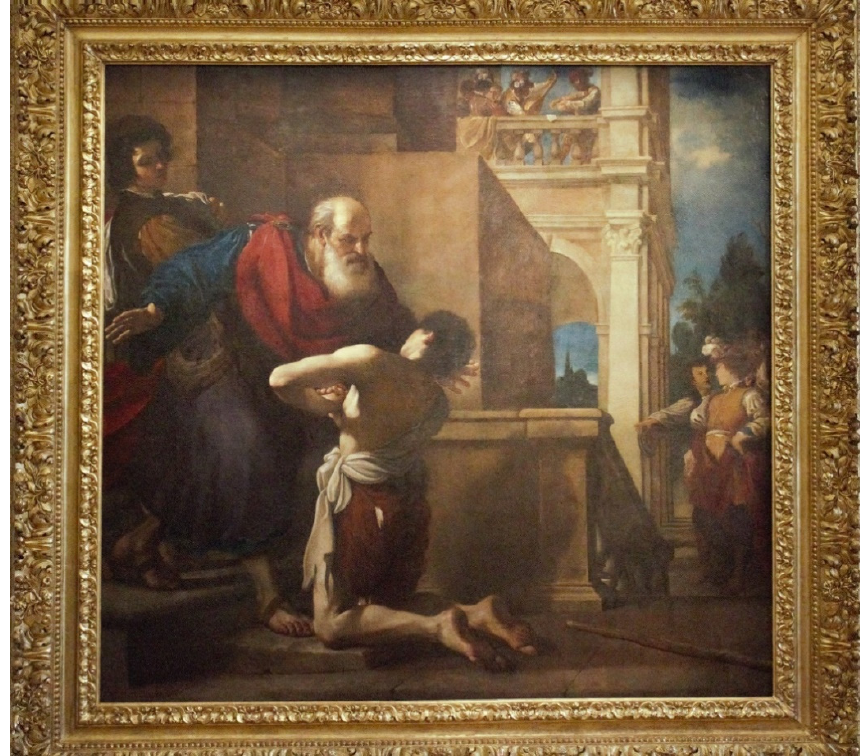
Figure 1. Guercino, Return of the Prodigal Son , 1618, Galleria Sabauda, Turin. Photo: © Daniel M. Unger.